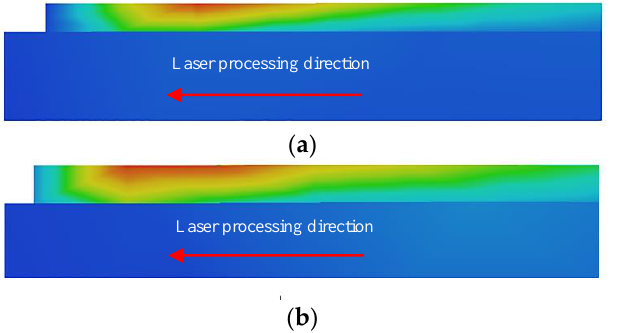
Figure 8. Effect of different energy densities on the melt pool depth: ( a ) ω = 41.7 J/mm 3 and ( b ) ω = 111.1 J/mm 3.